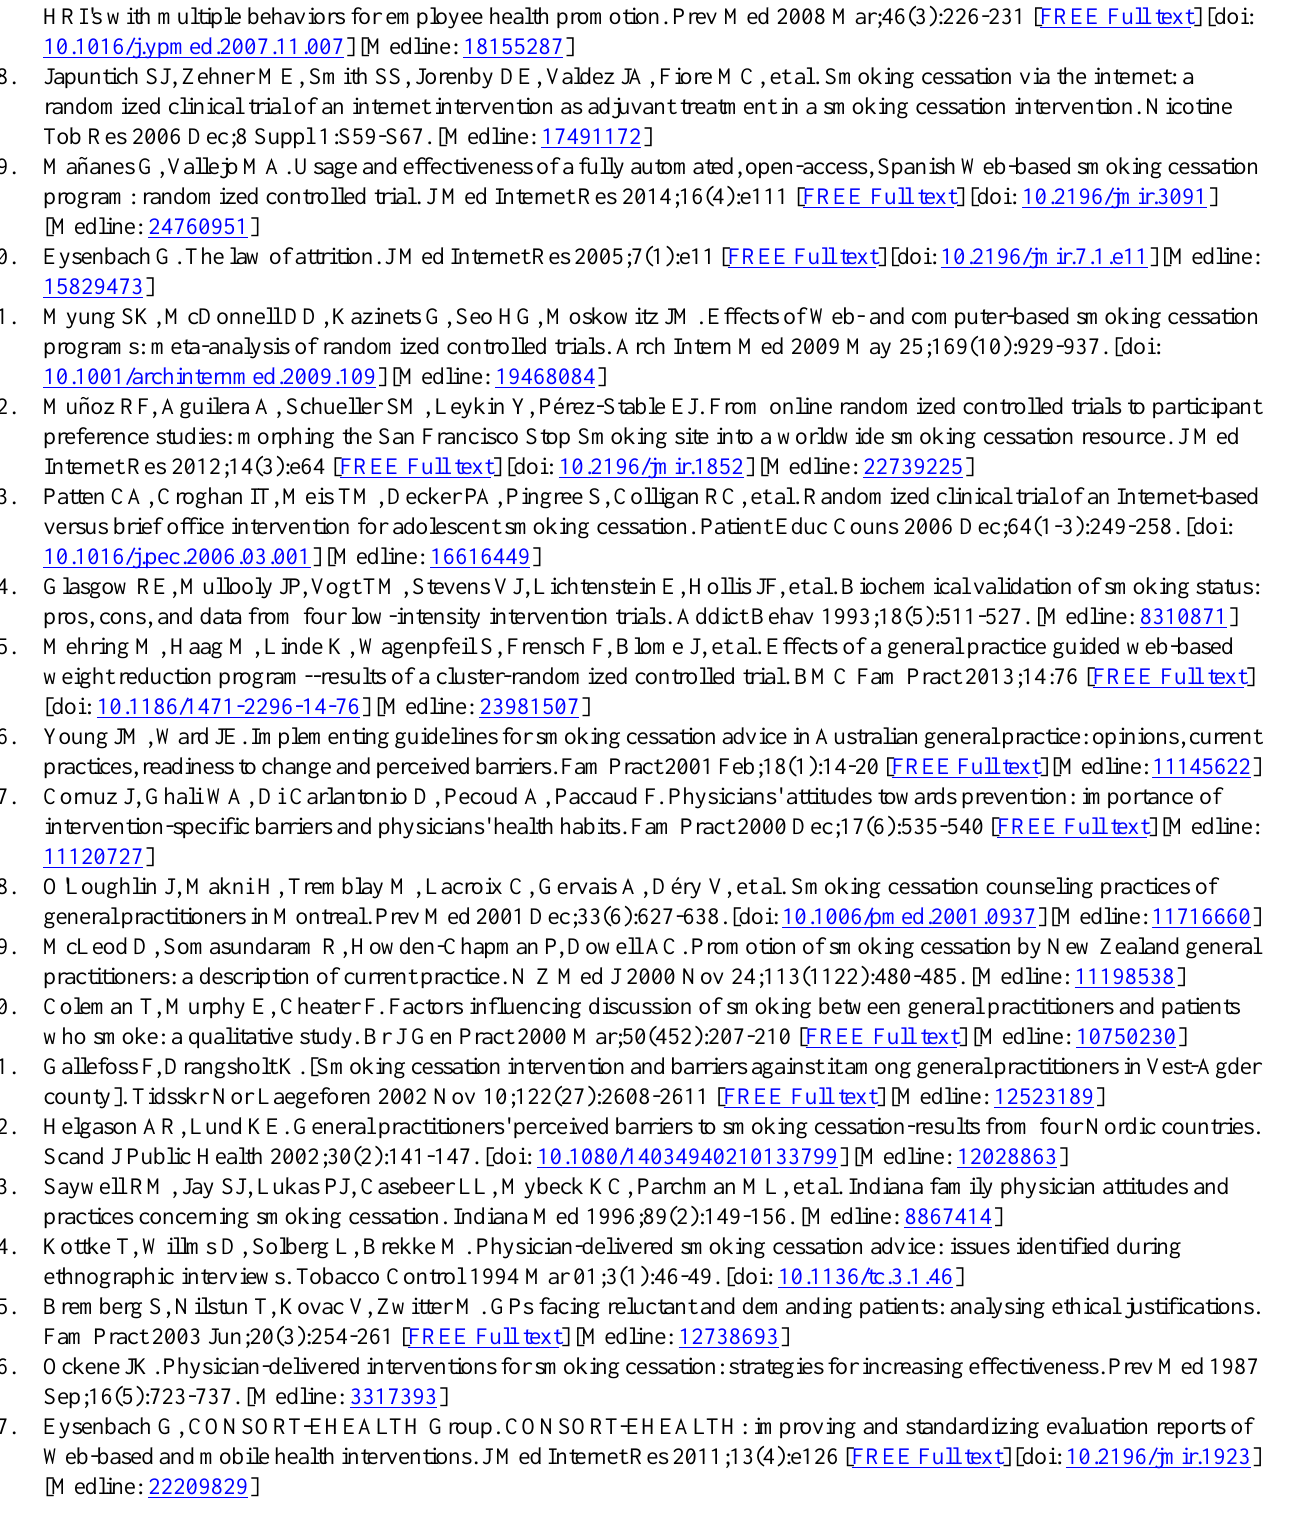
GP: general practitioner NRT: nicotine replacement therapy RCT: randomized controlled